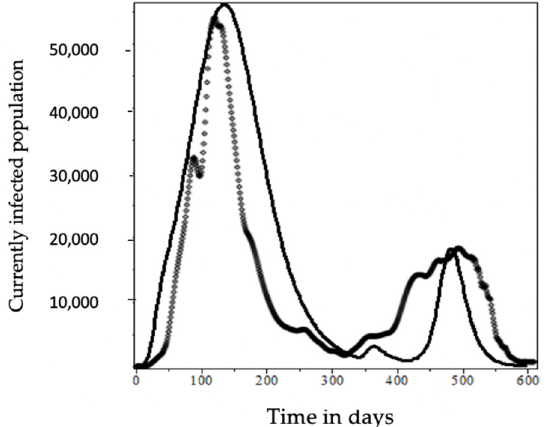
Figure 6. Time development of the transmission rate for the symptomatic population: ( a ) numerical results; ( b ) approximation by linear combinations of Gaussian radial functions.